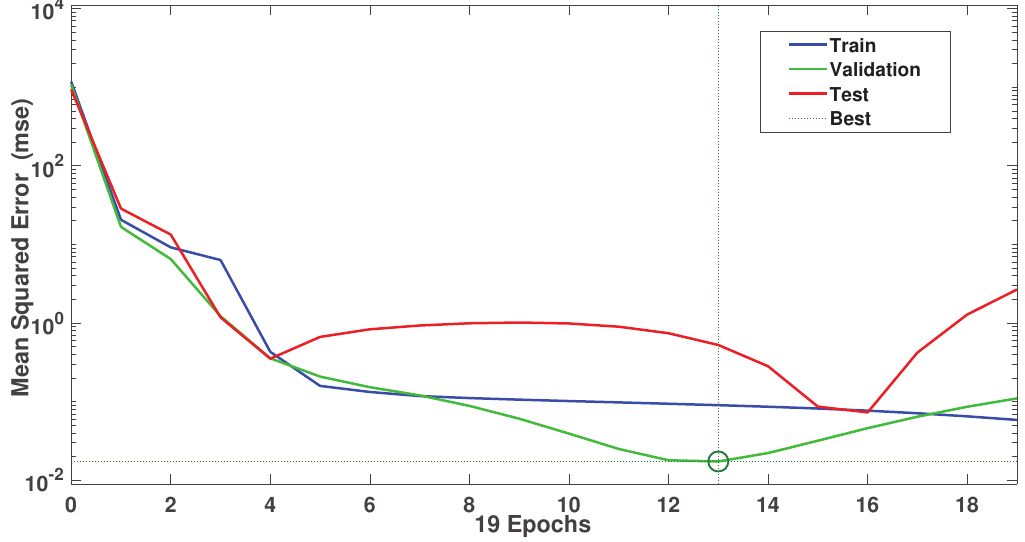
Figure 9. Mean square error of 19 Epochs for the ANN